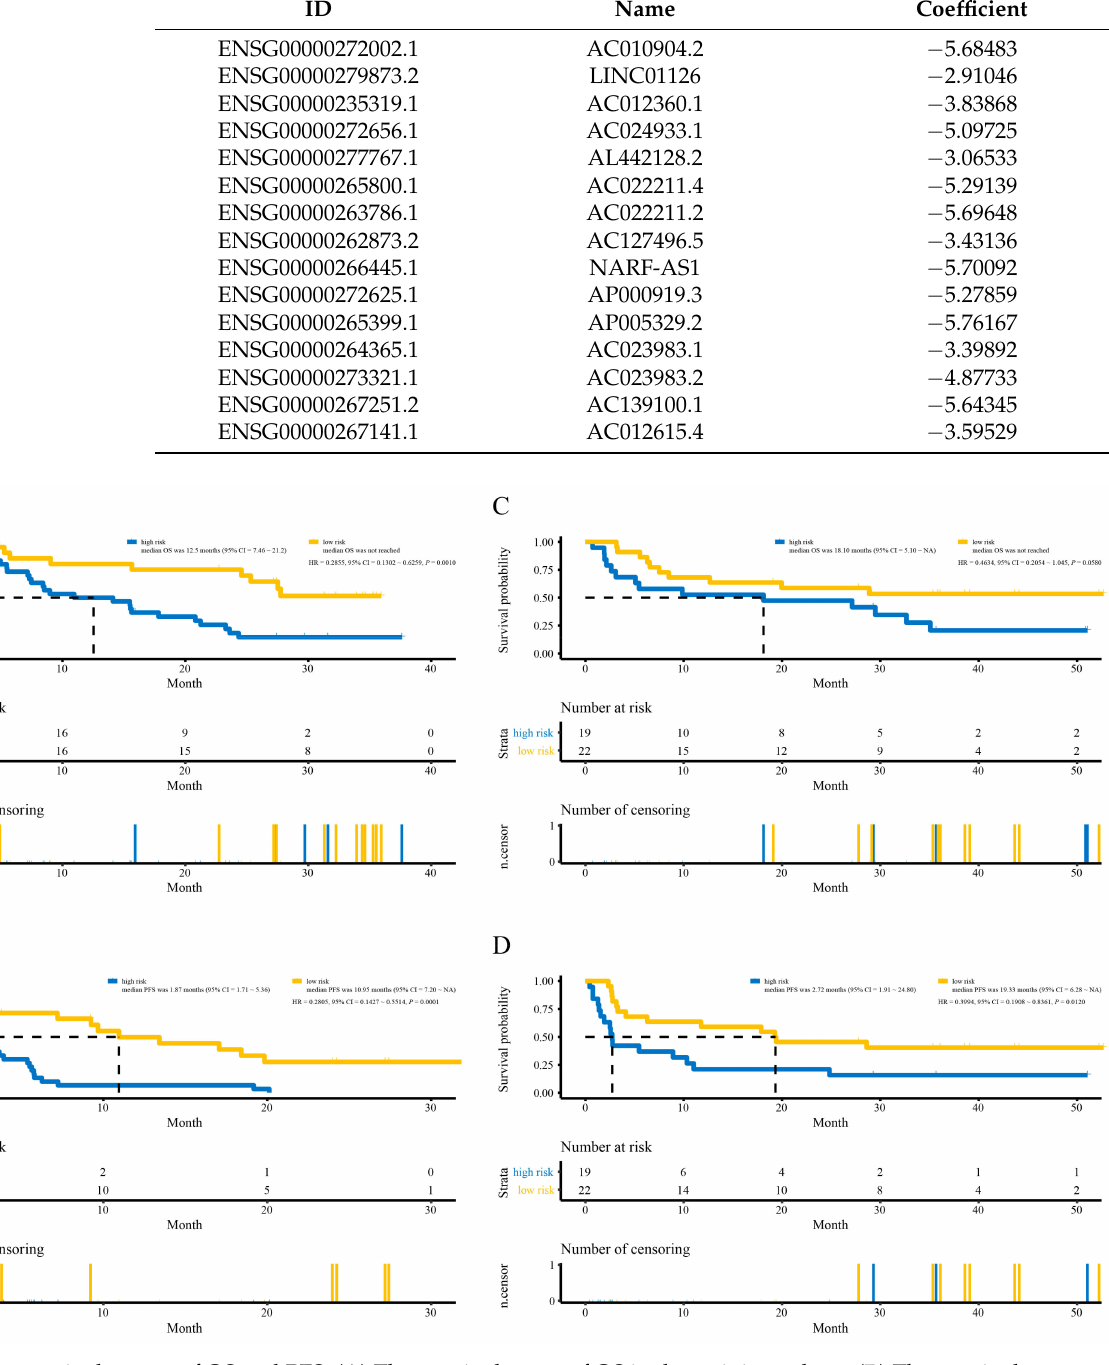
Figure 5. The survival curves of OS and PFS. ( A ) The survival curve of OS in the training cohort. ( B ) The survival curve of PFS in the training cohort. ( C ) The survival curve of OS in the validation cohort. ( D ) The survival curve of PFS in the validation